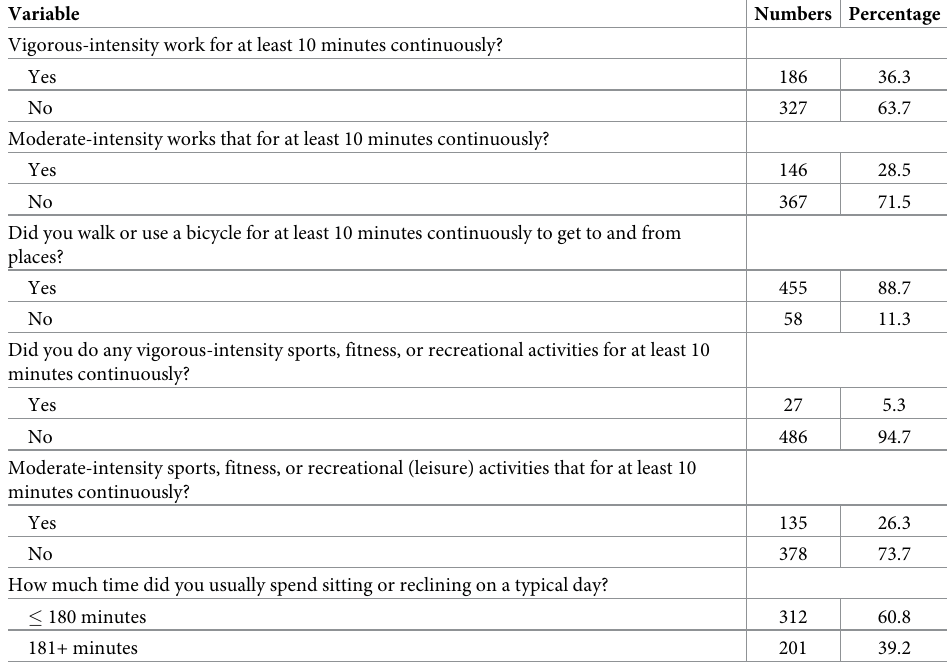
Table 4. Physical activities and sedentary behavior of the study participants (n =